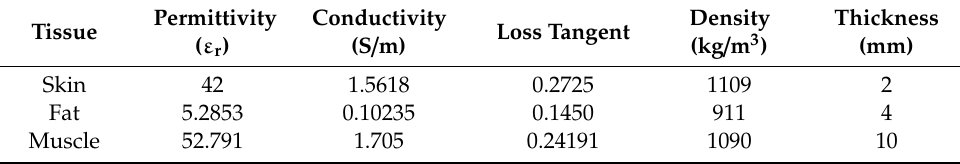
Table 3. Specification of human body tissues.